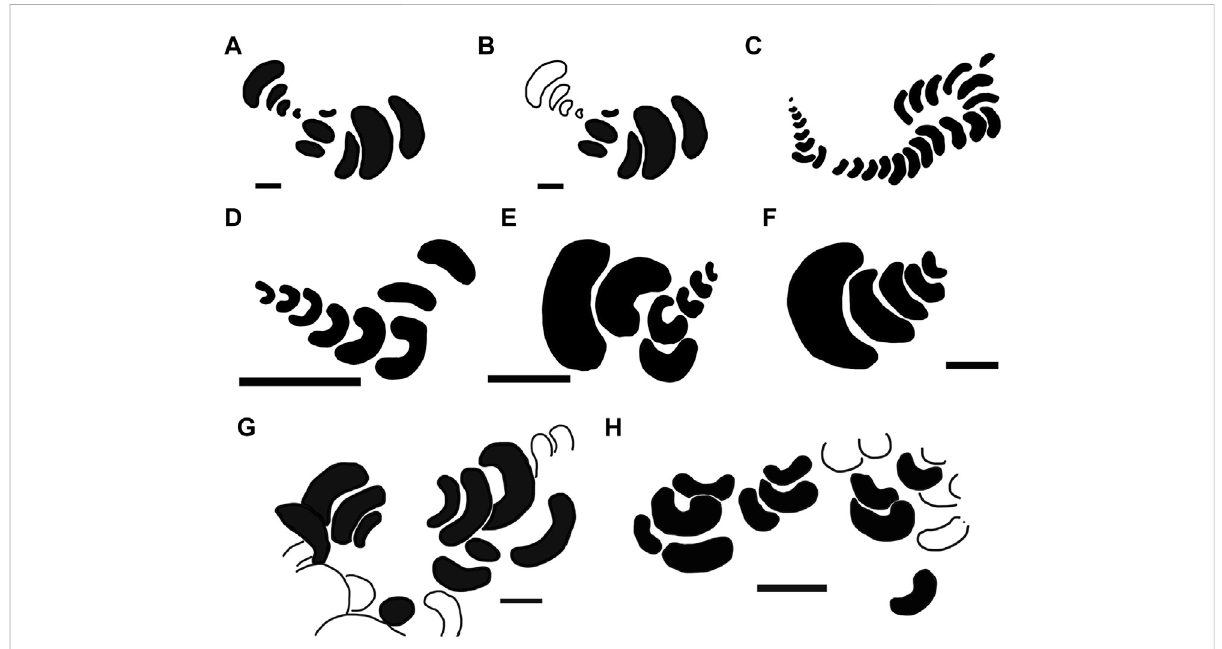
FIGURE 3 Schematic drawings of variants of Renichnus arcuatus (Mayoral, 1987), based on different occurrences from the literature (A – F) and this study (G – H) . (A,B) : type material of R . arcuatus (Mayoral, 1987) (Pliocene, Spain). (A) whole sample with holotype and paratype. (B) holotype highlighted in black. (C) Miocene of Poland (Radwa ń ski, 1969; 1977). (D) Maastrichtian of the Netherlands (Jagt, 2003). (E) Maastrichtian of Belgium (Jagt, et al., 2009). (F) Maastrichtian of Belgium (Donovan et al., 2011). (G) Playa del Aljibe, Fuerteventura, Spain, ULL PA 501. (H) Playa del Valle, Fuerteventura, Spain, ULL PA 473. White traces in (G,H) correspond to incomplete scars. Scales: (A,B) : 1 mm; (C) approximately 55 – 60 mm maximum in length; (D – F,H) 5 mm; (G) 2